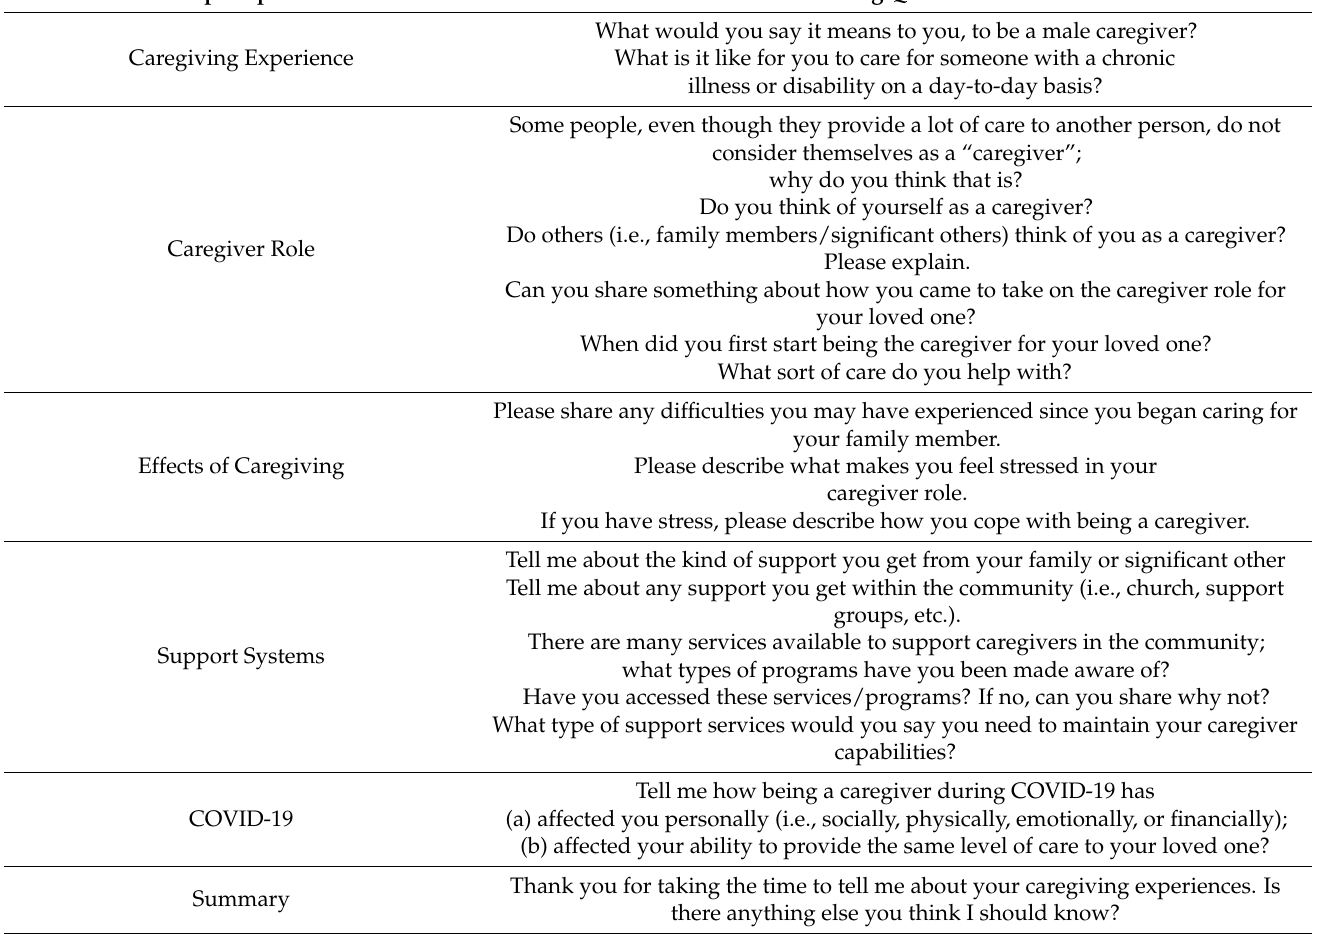
Table 1. Semi-structured interview guide for AA male caregivers of adult care recipients. Concept/Topic